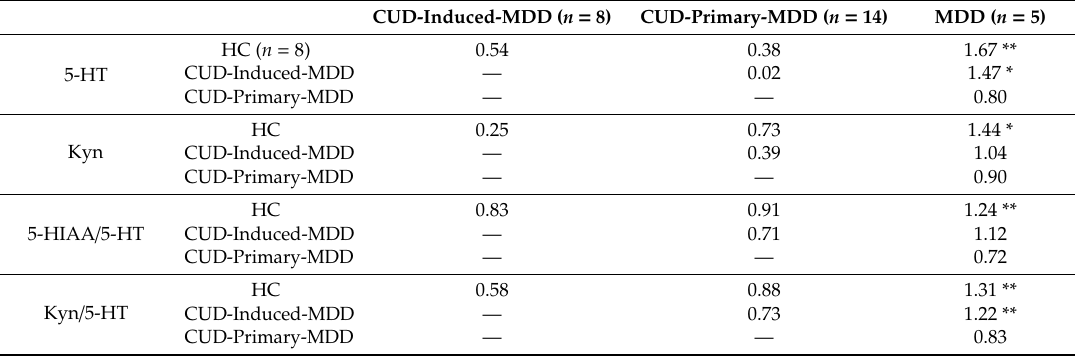
Table 3. E ff ect size coe ffi cient (Cohen’s d ) comparisons between groups in the four targeted